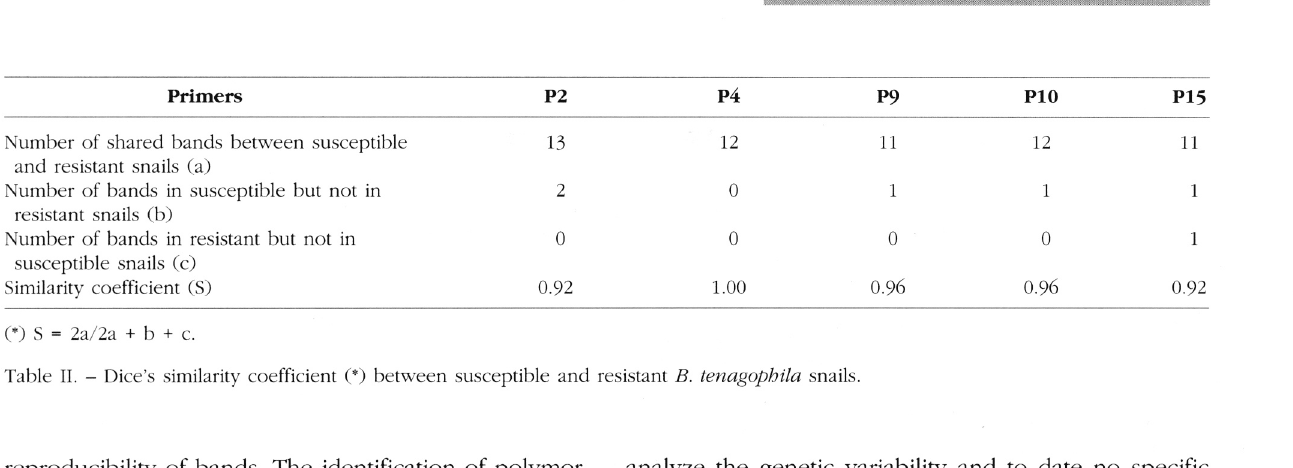
reproducibility of bands. The identification of